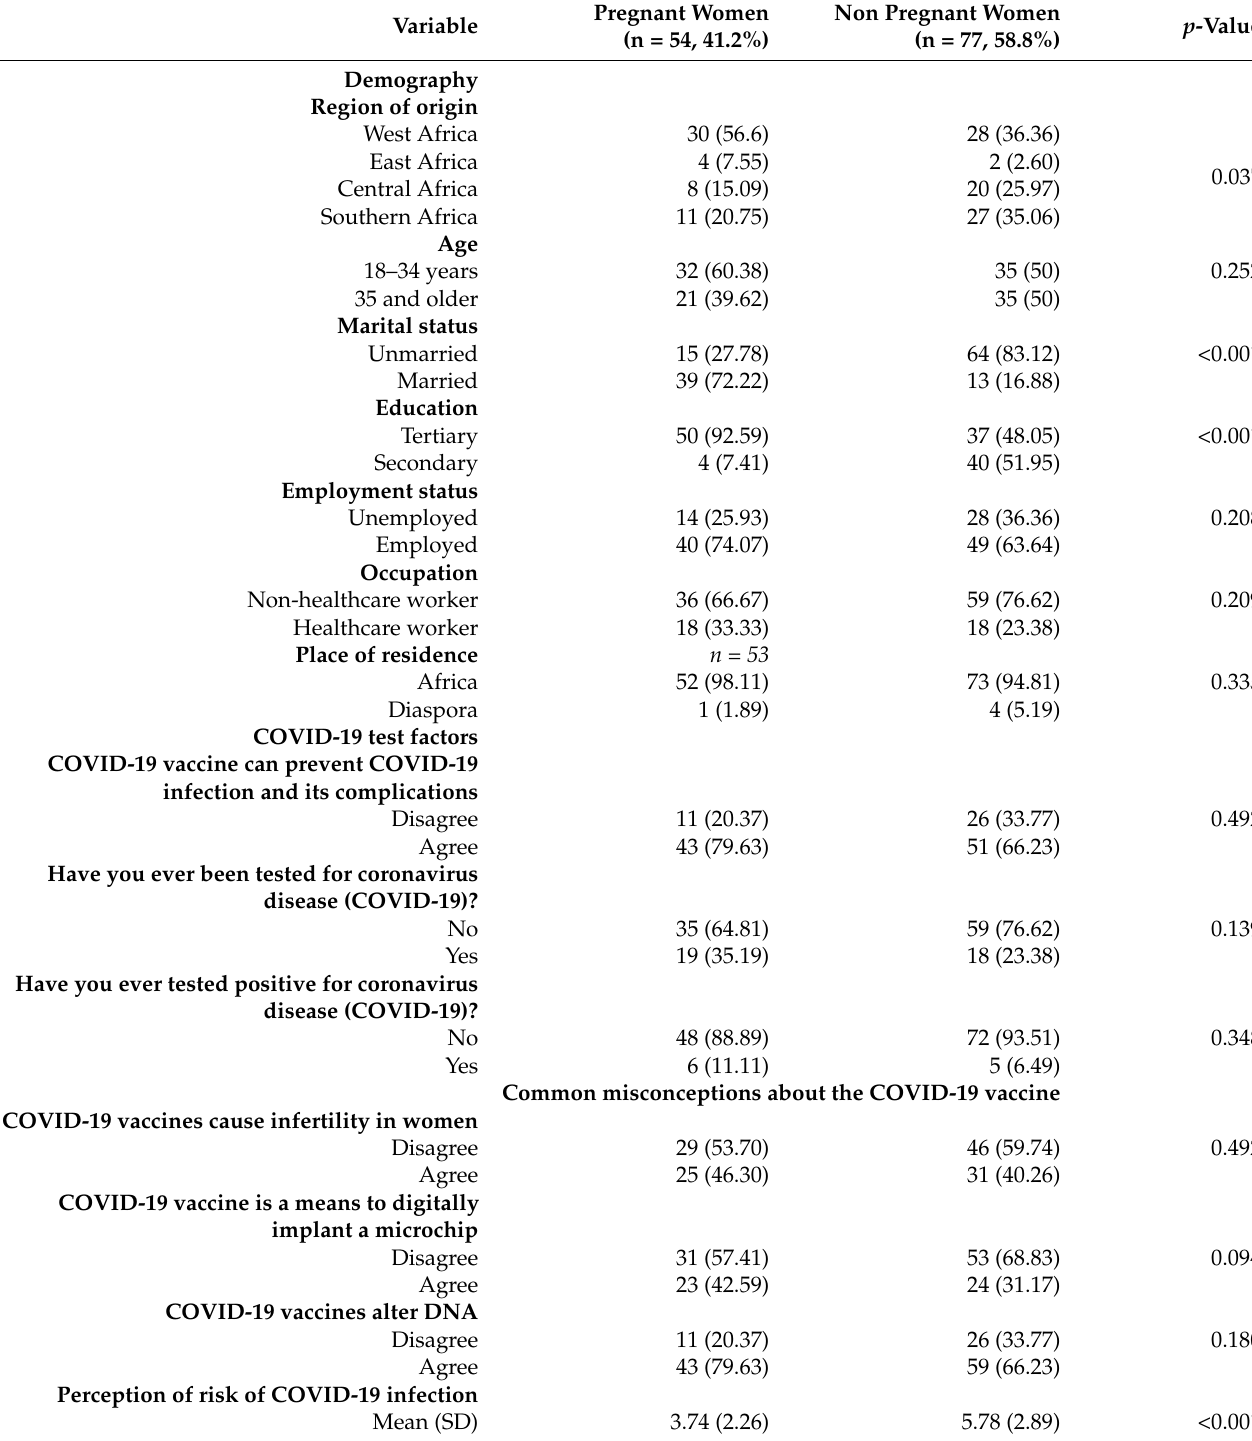
Table 1. Socio-demographic and COVID-19 testing among pregnant and non pregnant